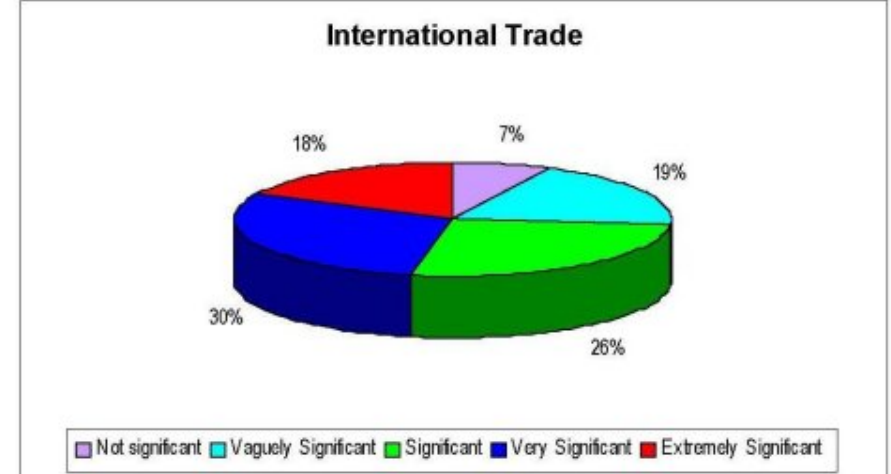
Figure 7 Respondent votes on the impact of international